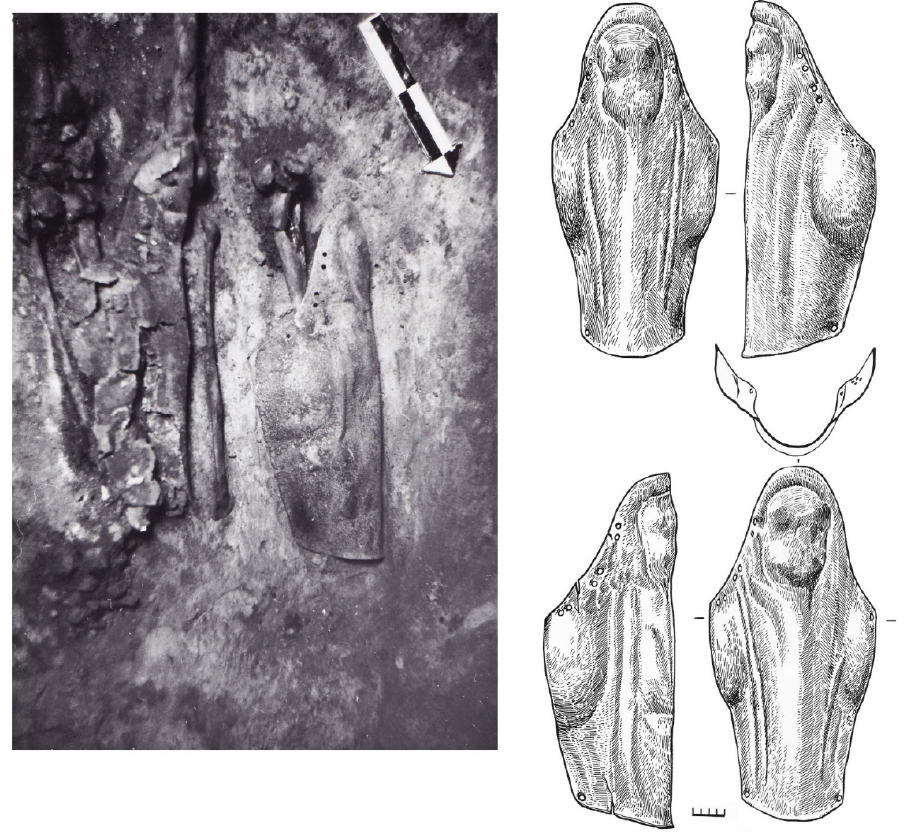
Figure 16. Pervomaevka Barrow 4, Burial 8. After G. Evdokimov (photograph and drawing from the personal archive of S. V. Polin).